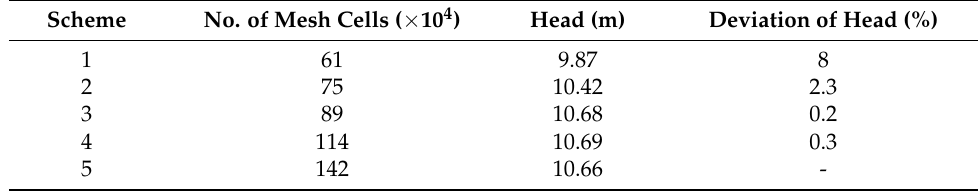
Figure 2. Computational domain model and mesh of pump. Table 2. Results of grid independence.